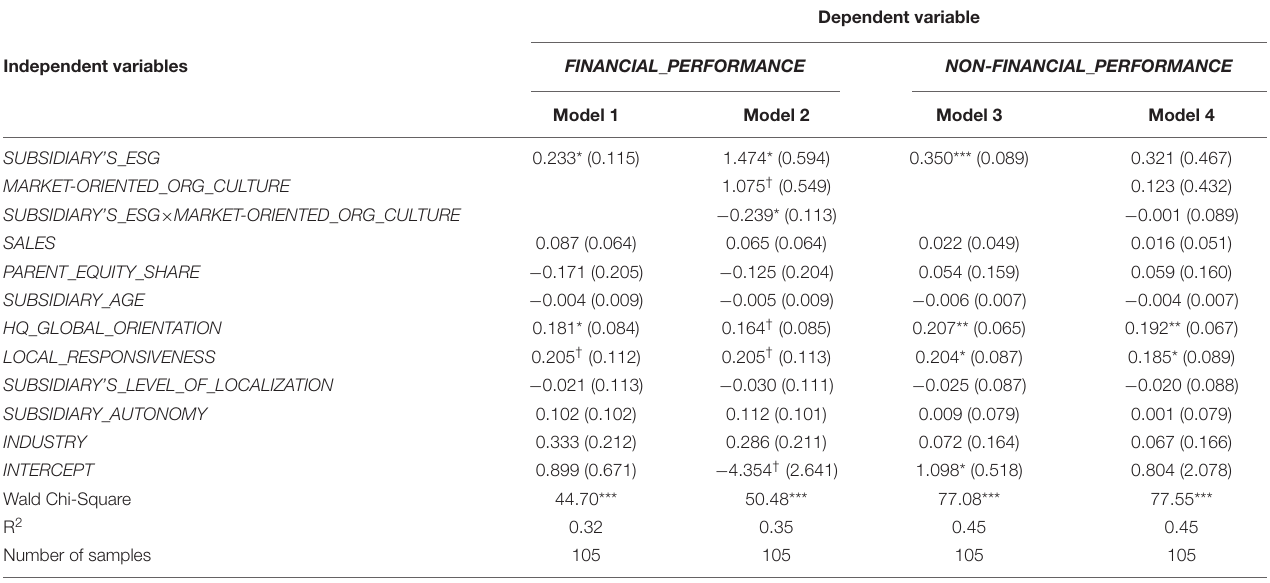
TABLE 5 | The moderate effect of market-oriented organizational